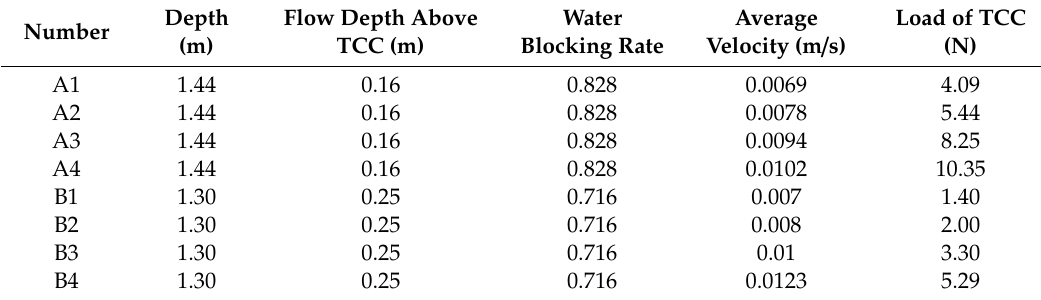
Table 2. Scenarios and results of the physical model